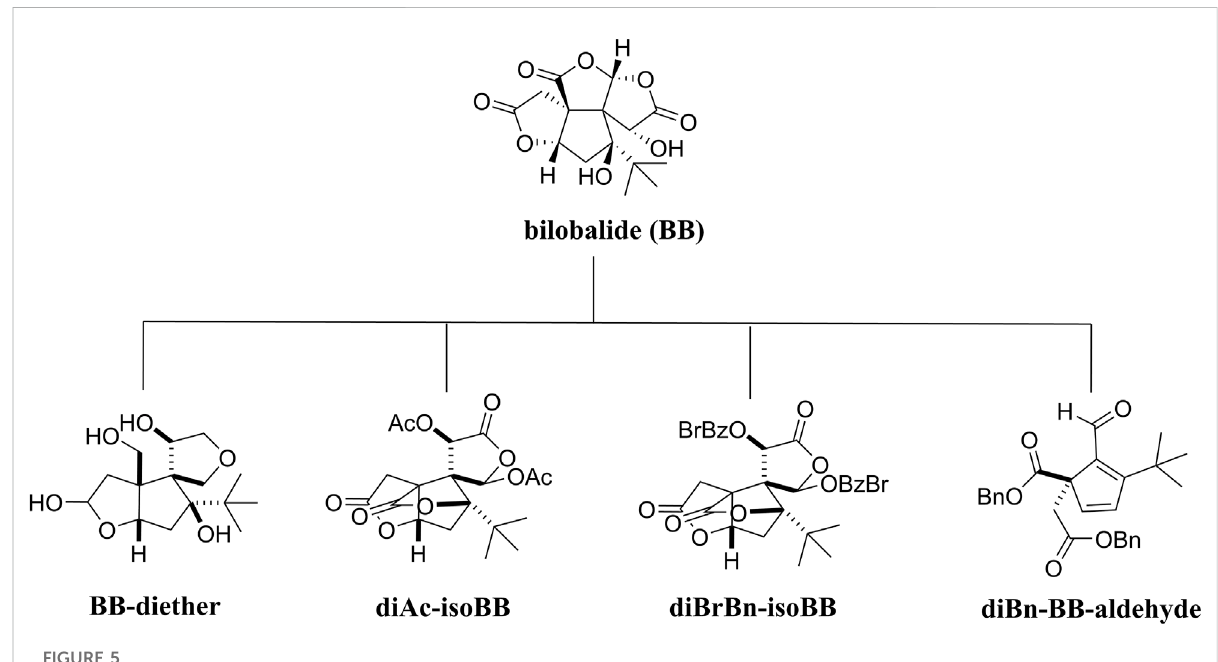
FIGURE 5 Bilobalide and its